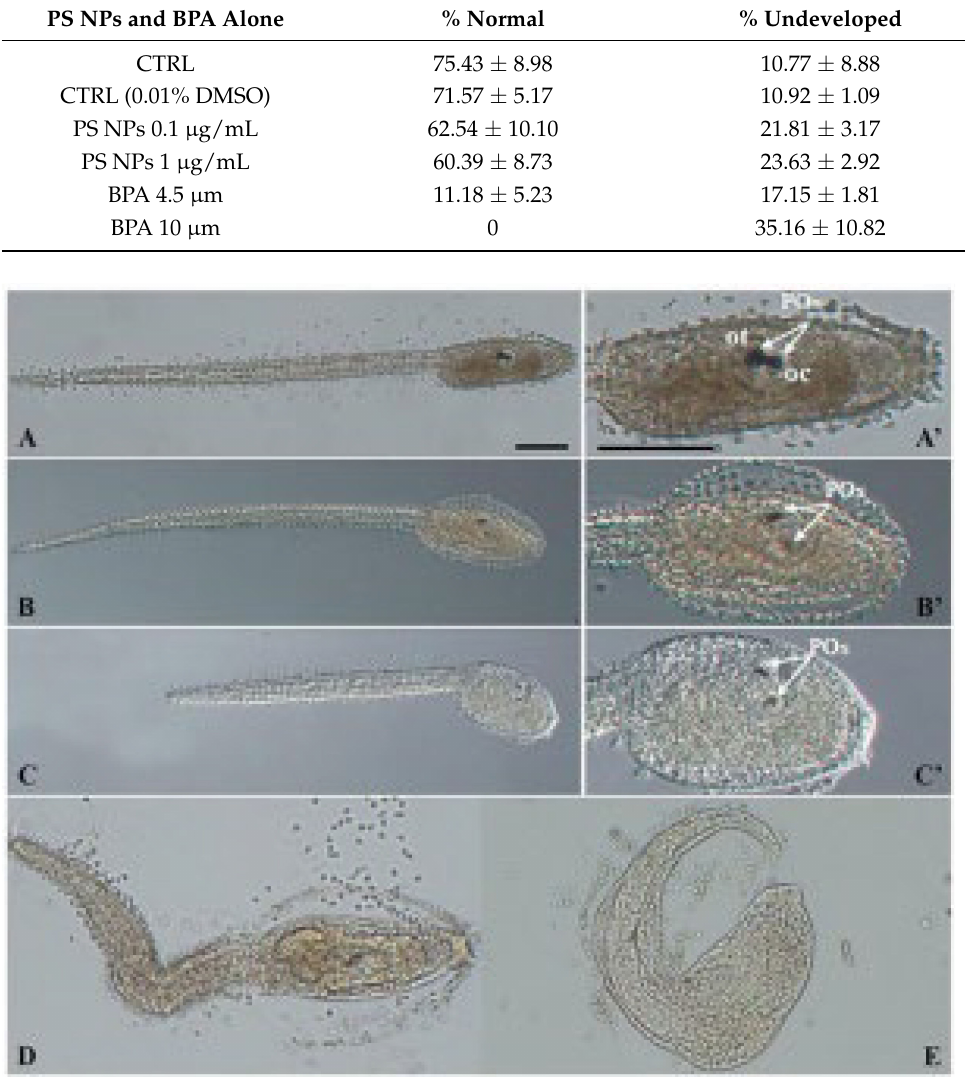
Figure 2. Light microscopy images of representative C. robusta larvae with general malformations and mild malformations (reduced pigmentation) upon exposure to BPA alone and combined with PS NPs: controls ( A , A’ ), mild malformations ( B , B’ , C , C’ ) and general malformations ( D , E ). White arrows indicate otolith (ot) and ocellus (oc) which together form the pigmented organs (POs). Scale bars: 100 µ